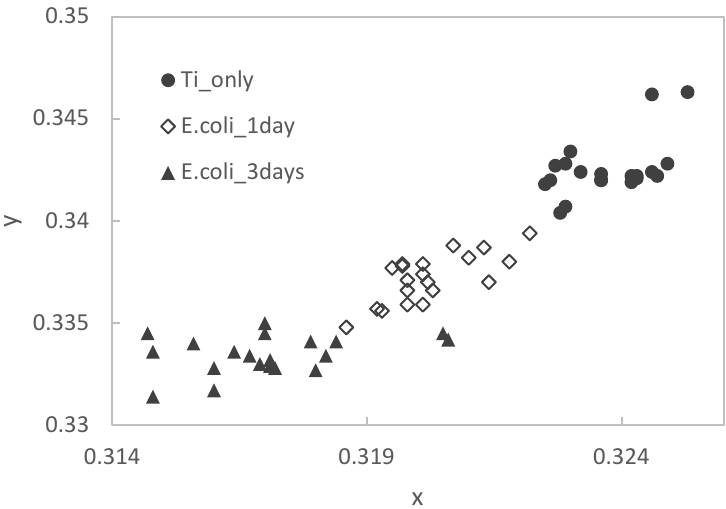
Figure 5. Color changes of stained pure titanium specimens with immersion times. The dots in the upper right of the figure for the Ti substrate only shift to the lower left as the immersion period in the E. coli culture medium increases. The mean values and standard deviations of the colorimetric measurements of Ti substrate and Ti specimen immersed in E. coli culture medium for 3 days are shown in Table 1 below. Table 1. Average values and their standard deviations for stained titanium specimens.